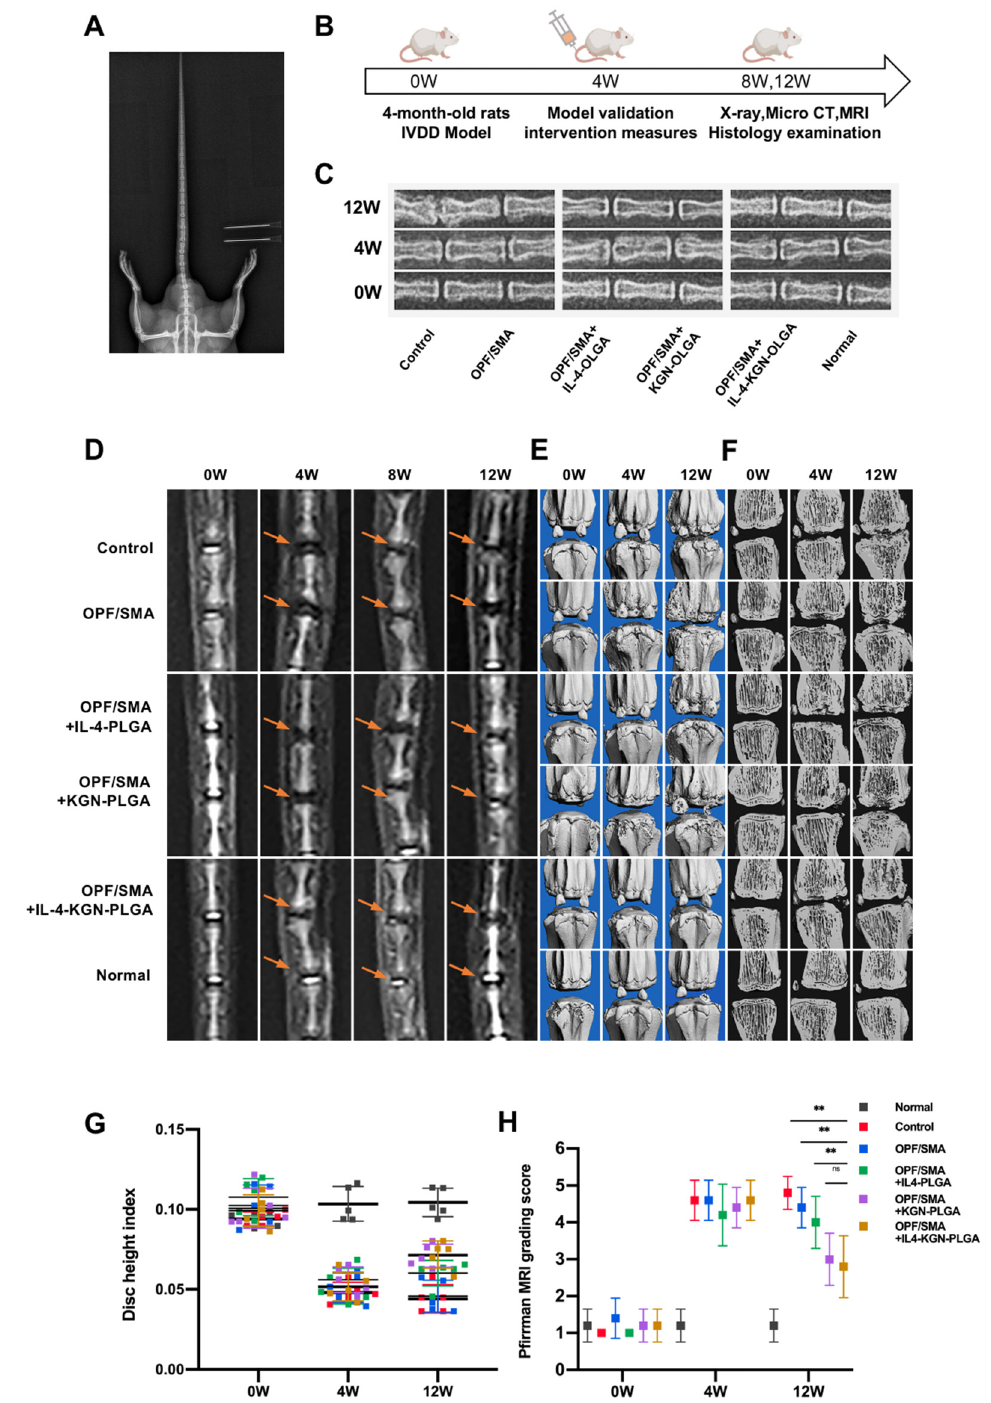
Figure 6. Therapeutic effect of OPF/SMA composite hydrogel in vivo. ( A , B ) Animal model and intervention time point. ( C ) Rat intervertebral discs can be seen on X-rays. Eight weeks following modeling. ( D – F ) At 4 and 8 weeks after modeling, MRI analysis and Micro-CT examination of the rat intervertebral disc were performed. ( G , H ) Eight weeks following surgery, changes in the caudal intervertebral DHI and Pfirrman MRI grading score of the caudal intervertebral disc in rats. The mean ± SD ( n = 5) was used to express data. Two-way ANOVA was used to calculate statistical significance. ** p < 0.01, ns >